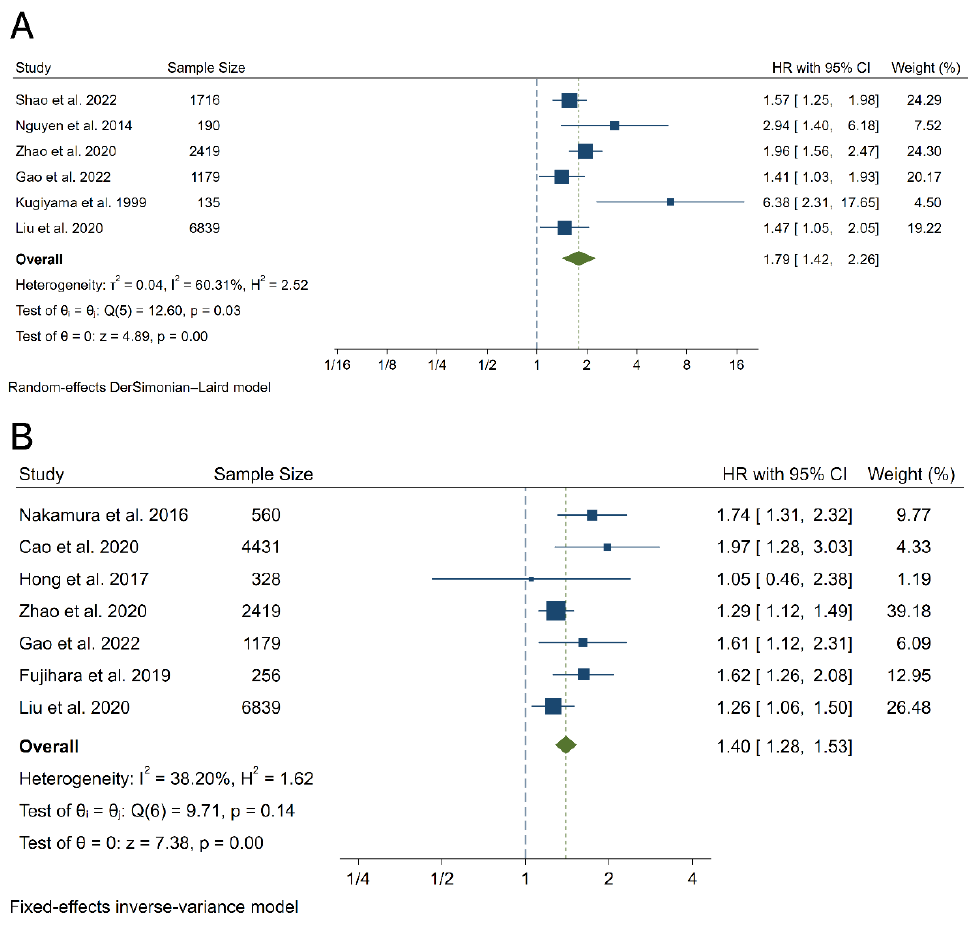
Figure 2. Forest plots for the meta-analysis of the association between the RLP-C and the risk of MACEs. ( A ) Meta-analysis with the RLP-C analyzed as a categorical variable. ( B ) Meta-analysis with the RLP-C analyzed as a continuous variable. References involved in the study: